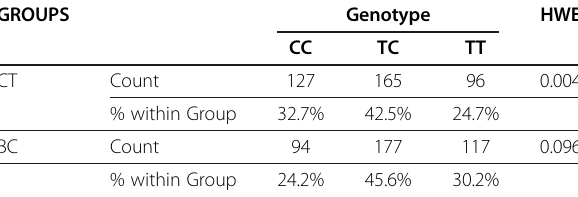
Table 2 Genotype distribution in the CT and BC